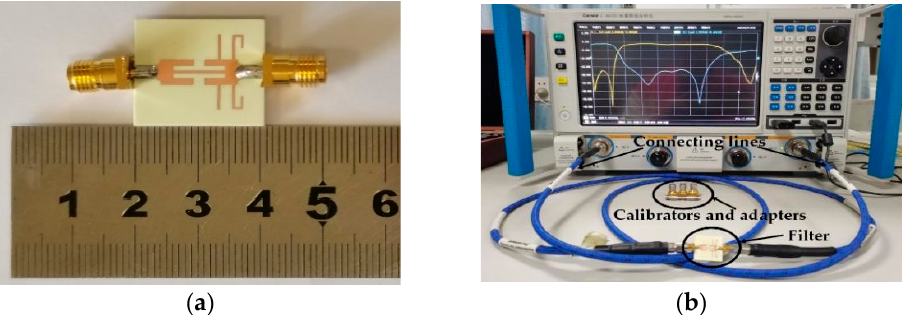
Figure 9. Photograph of ( a ) the fabricated UWB filter and ( b ) measurement scene.